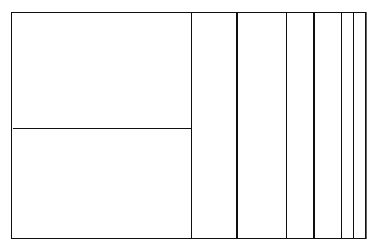
Figure 3: Example of treemap subdivision generating rectangles with aspect ratio di ff erent from